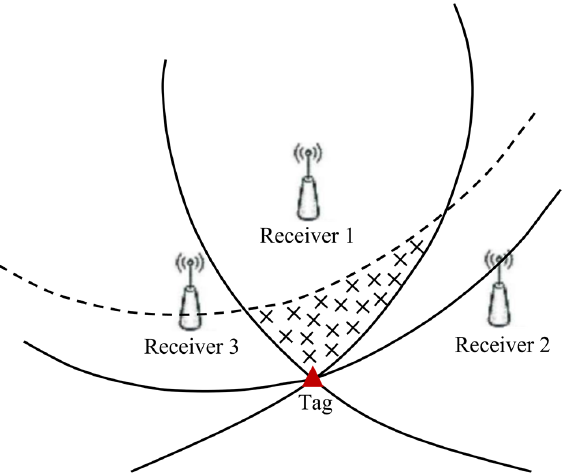
Figure 1. The effect of NLOS error on positioning accuracy.